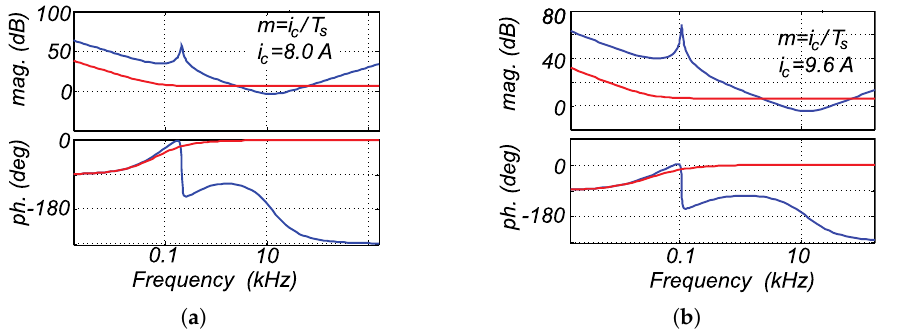
Figure 17. Frequency response, voltage control, F m ( G id ( s ) F hf ( s ) + C v ( s ) G vd ( s ) + F v G vd ( s )) (blue curve) and C v ( s ) (red curve), for ( a ) buck and; ( b ) boost controller design.